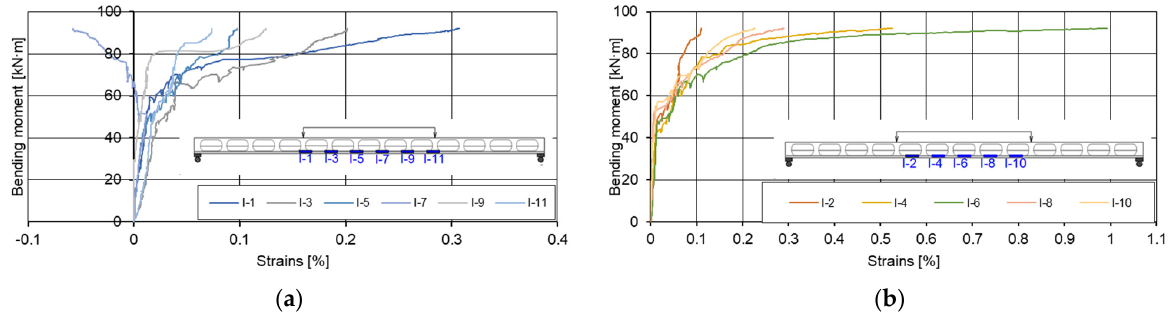
Figure 21. Graphs of bending moments: strains of the first slab (I pl) at the level of pretensioned reinforcement. ( a ) Strains between the plastic inserts and ( b ) strains at the place of the plastic inserts.